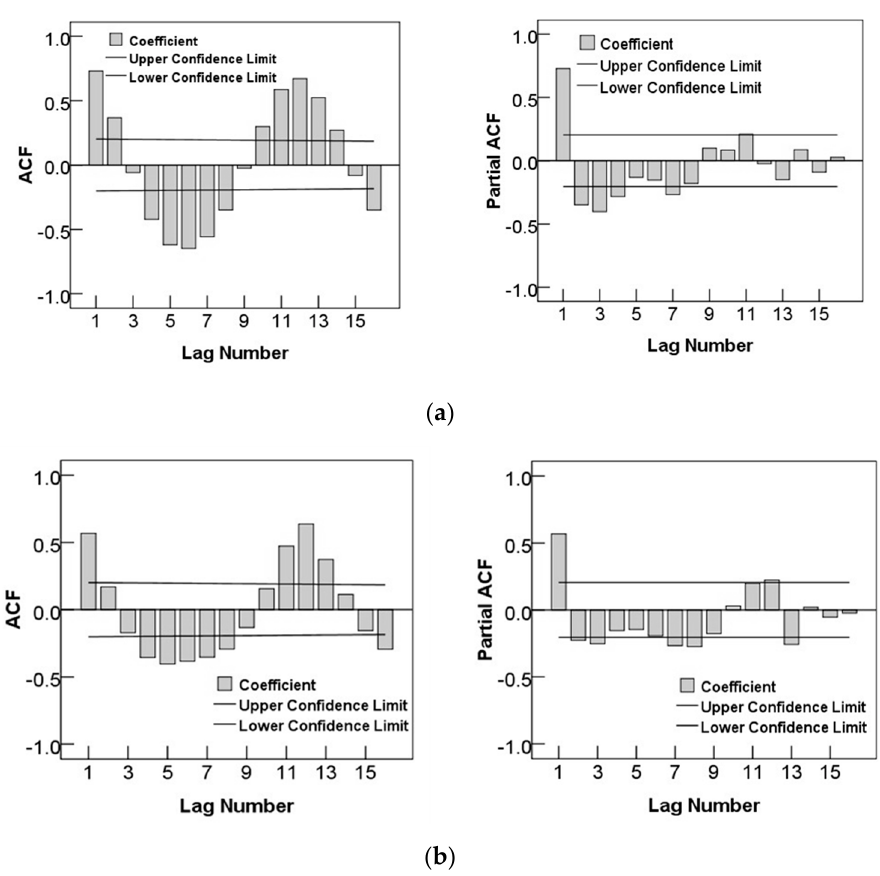
Figure 7. ACF and PACF of Runoff and Sediment into the TGP: ( a ) Runoff; ( b ) Sediment.